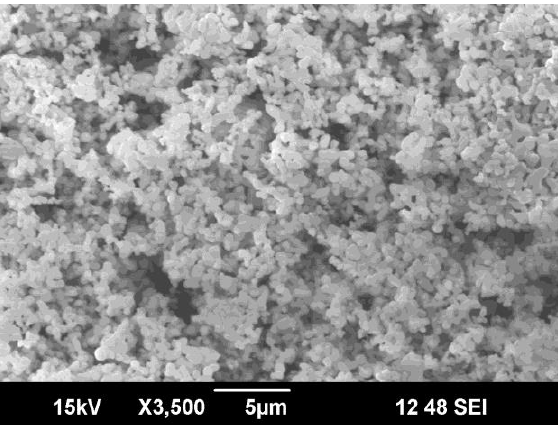
Figure 2. SEM micrograph of as-prepared Mg-HA.